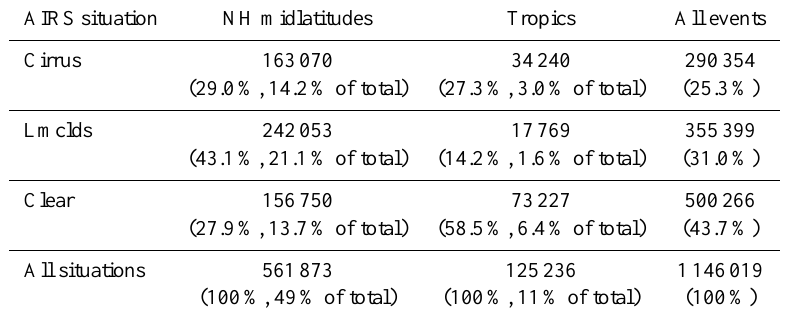
Fig. 2. Top: ratio of MOZAIC measurements taken in summer compared to the winter plus summer statistics. Bottom: average delay (in days) between two overpasses by MOZAIC flights. Table 3. Statistics of AIRS-MOZAIC collocations (one MOZAIC single measurement per AIRS footprint) in the upper troposphere sepa- rately for different AIRS cloud types. In brackets relative percentage with respect to latitude bands and